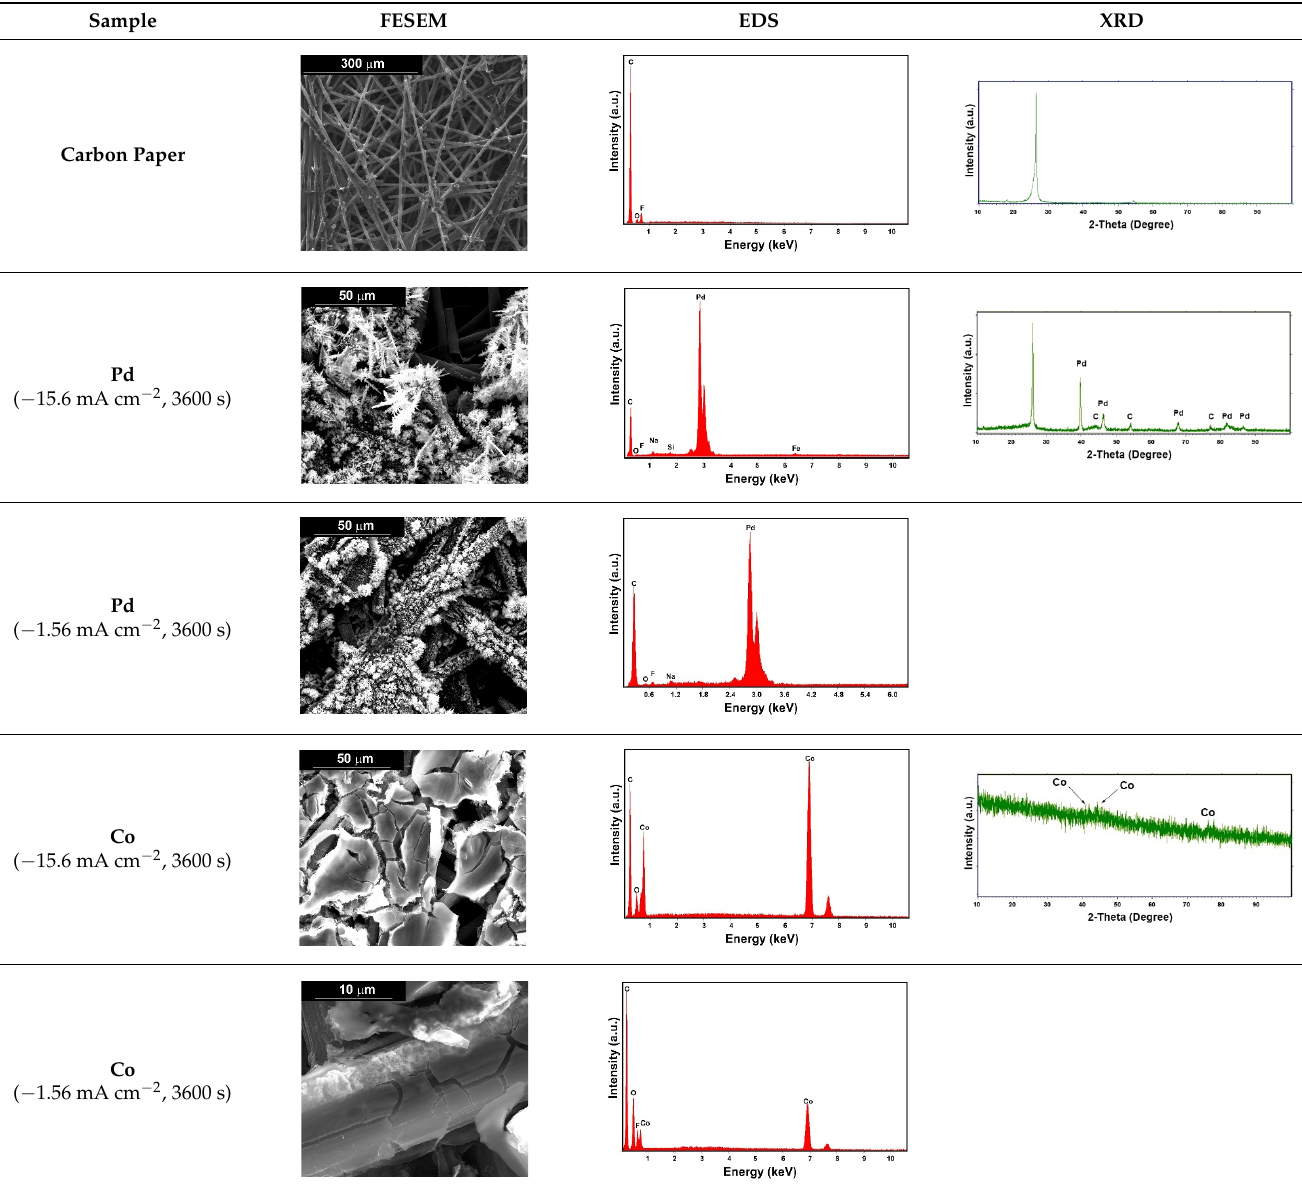
Table 1. The FESEM, EDS and XRD of the CP and Pd and Co deposits; the electrodeposition conditions and the composition of the electrodeposition bath is also reported.